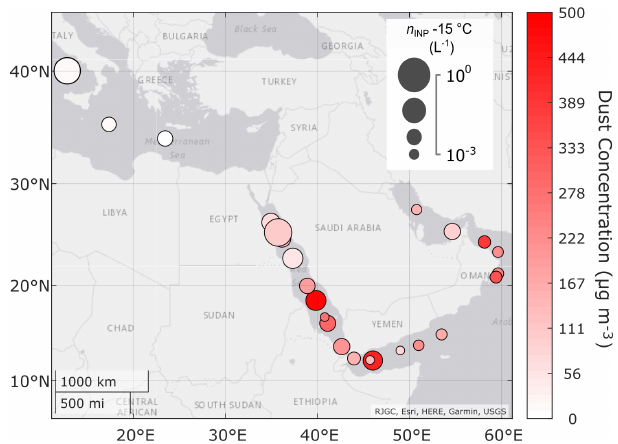
Figure 1. Map of the sample locations for 26 aerosol samples col- lected on the RV Kommandor Iona during Air Quality and Climate Change in the Arabian Basin (AQABA; see also Figs. S1–S2 and S9–S10). Measured n INP spanned 2 orders of magnitude at − 15 ◦ C, from 5 × 10 − 3 to 5 × 10 − 1 L − 1 . Marker sizes indicate abundance of INPs. Marker colors indicate the average ambient dust mass con- centration during the sampling period from hourly MERRA-2 re- analysis